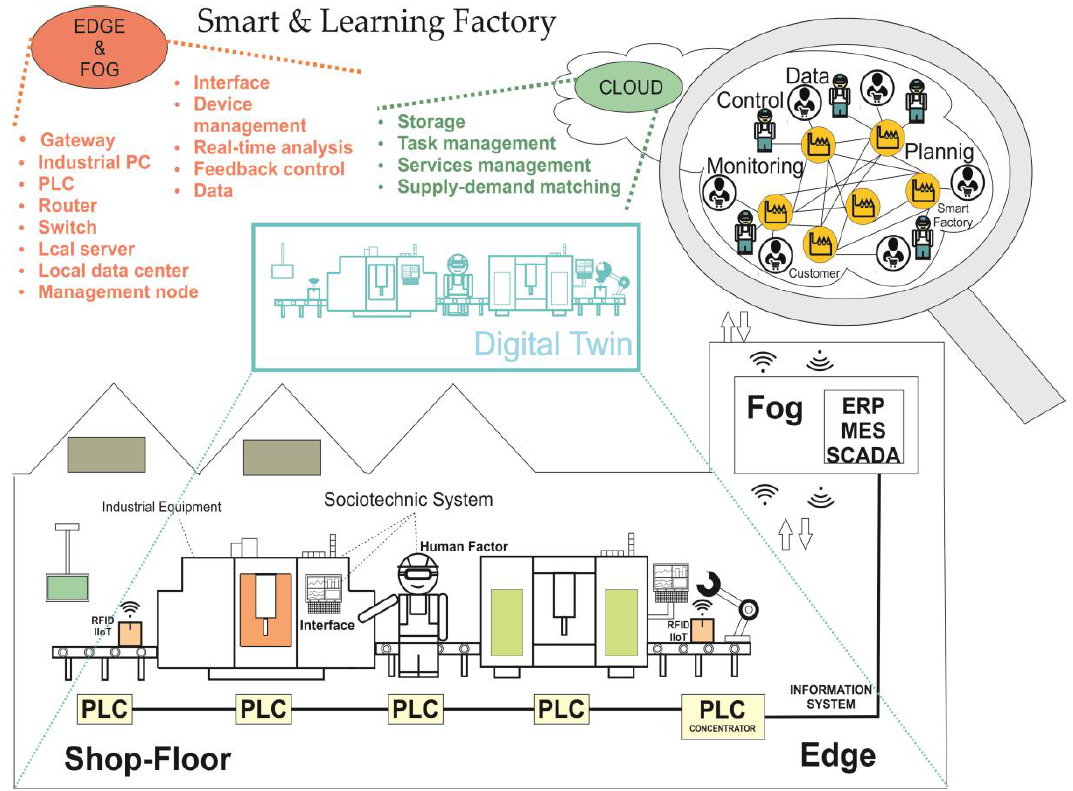
Figure 6. Connectivity in the Smart and Learning Factories.